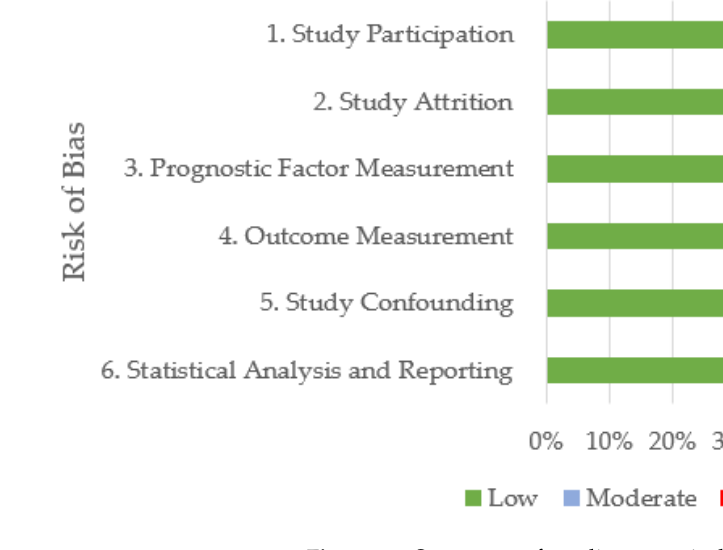
Figure 2. Summary of quality appraisal for the 20 reviewed publications using the Quality in Prognosis Studies (QUIPS) tool. Quality was assessed as having low, moderate, or high risk of bias across six domains.